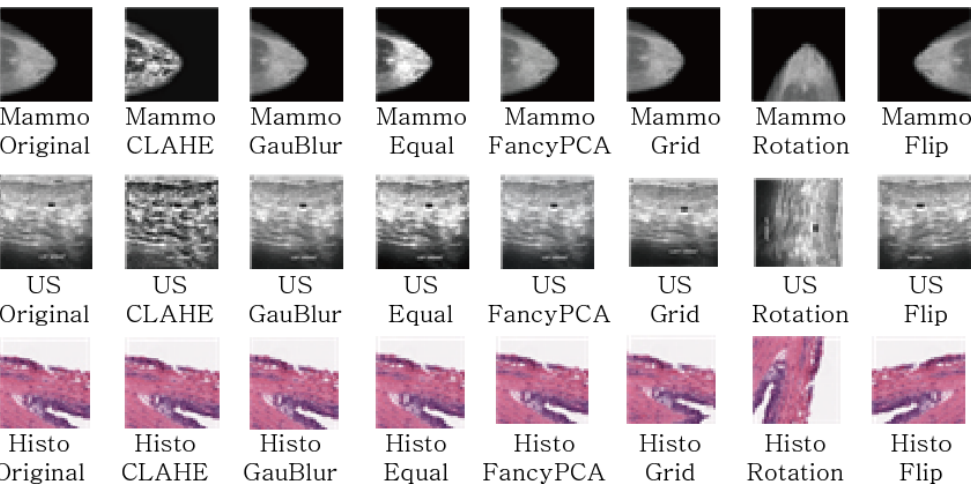
Figure 3. The Examples of Data Argumentation